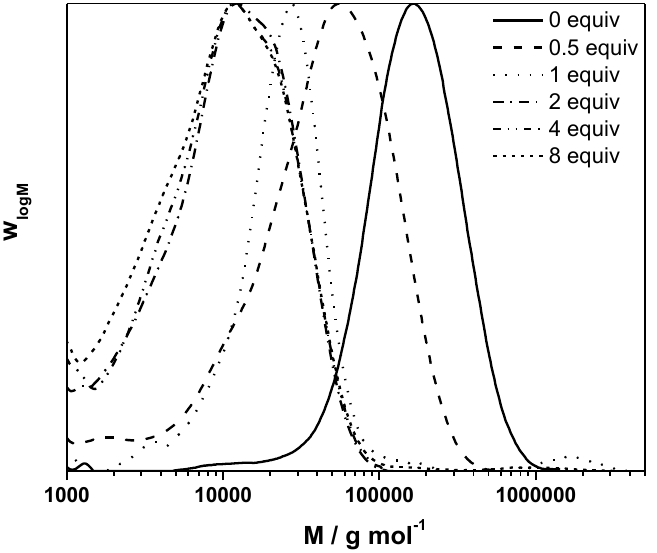
Figure A2. SEC profile of CPM-PPV obtained by polymerization of the sulfinyl CPM premonomer in the presence of specified amounts of CBr 4 as CTA, followed by elimination of the precursor polymer into conjugated